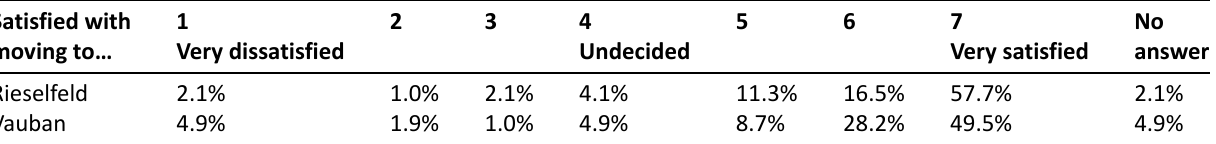
Table 6. Level of satisfaction with moving to Rieselfeld/Vauban. Satisfied with